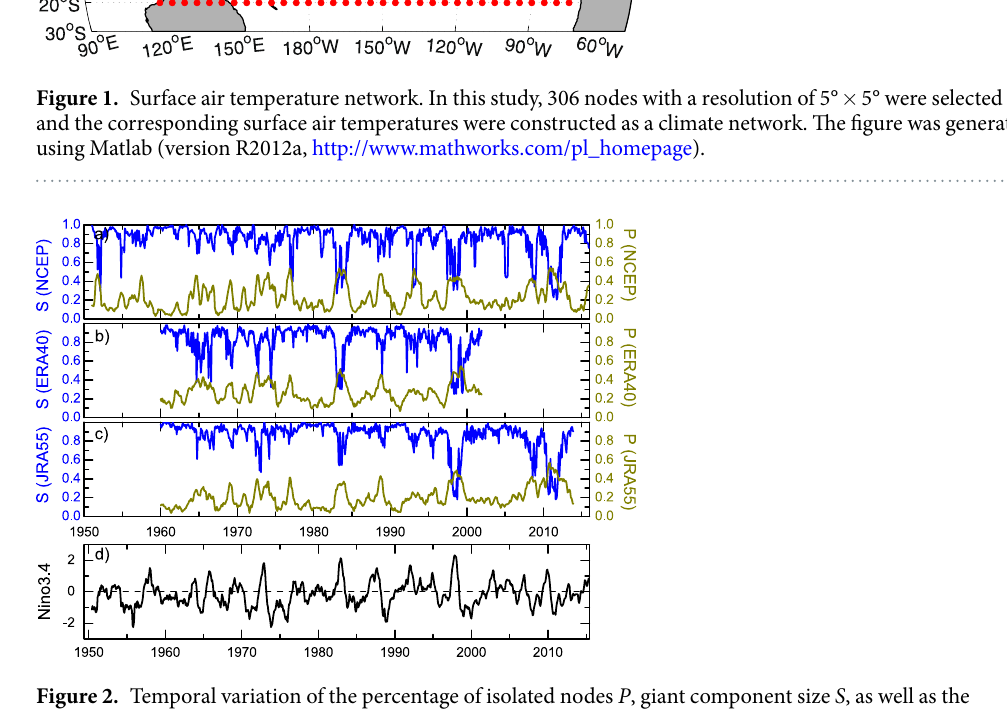
cluster still spans the entire network, while a small S indicates that the network has been divided into many small pieces. An abrupt change of S from a high level to a low level indicates a change of the network state, or, in other